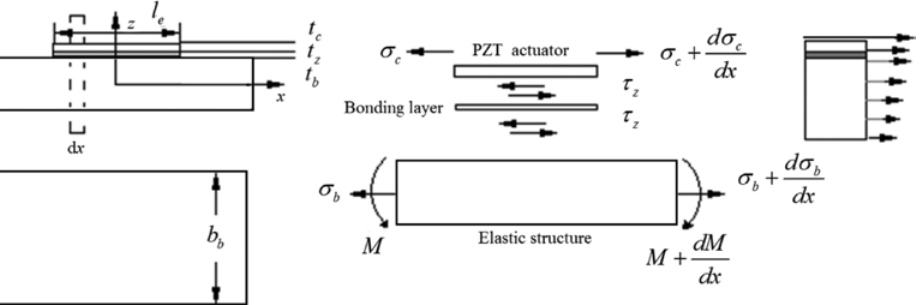
Figure 2: The actuating model of piezoelectric